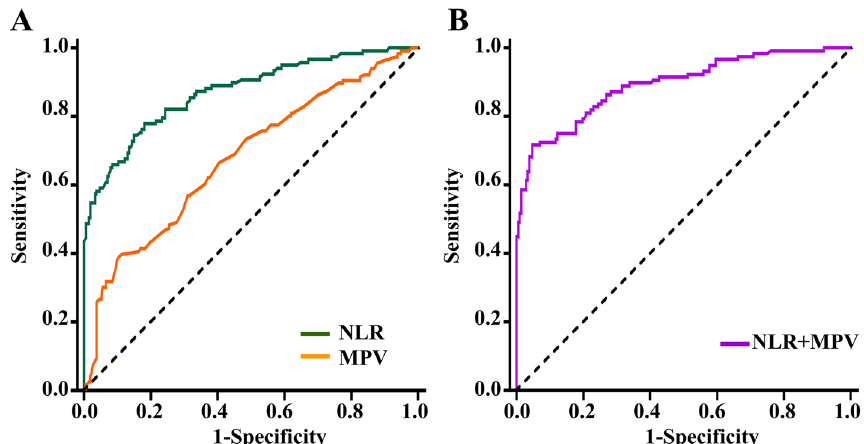
Fig. 1 ROC curve for the validity of NLR, MPV, and combined NLR